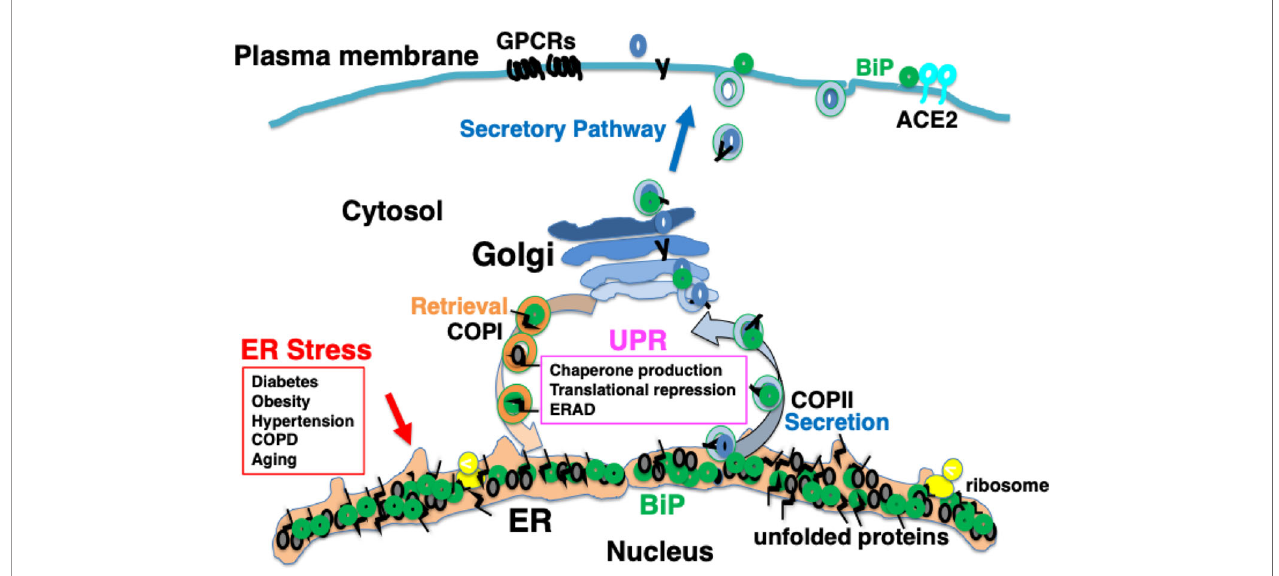
FIGURE 3 | Chronic comorbidity is associated with ER stress. Among patients with complications and elderly people, protein folding in the ER is impaired to a certain extent; therefore, the ability of the UPR to accommodate further ER stress may be